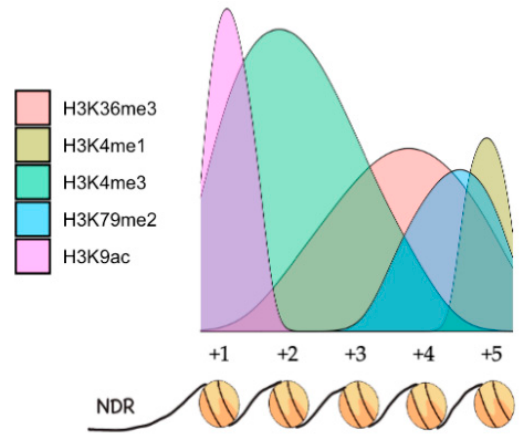
Figure 2. Schematic representation of the distribution of different posttranslational modifications (PTMs) in nucleosomes after the nucleosome-depleted region (NDR), in a hypothetical gene comprised of only five nucleosomes.